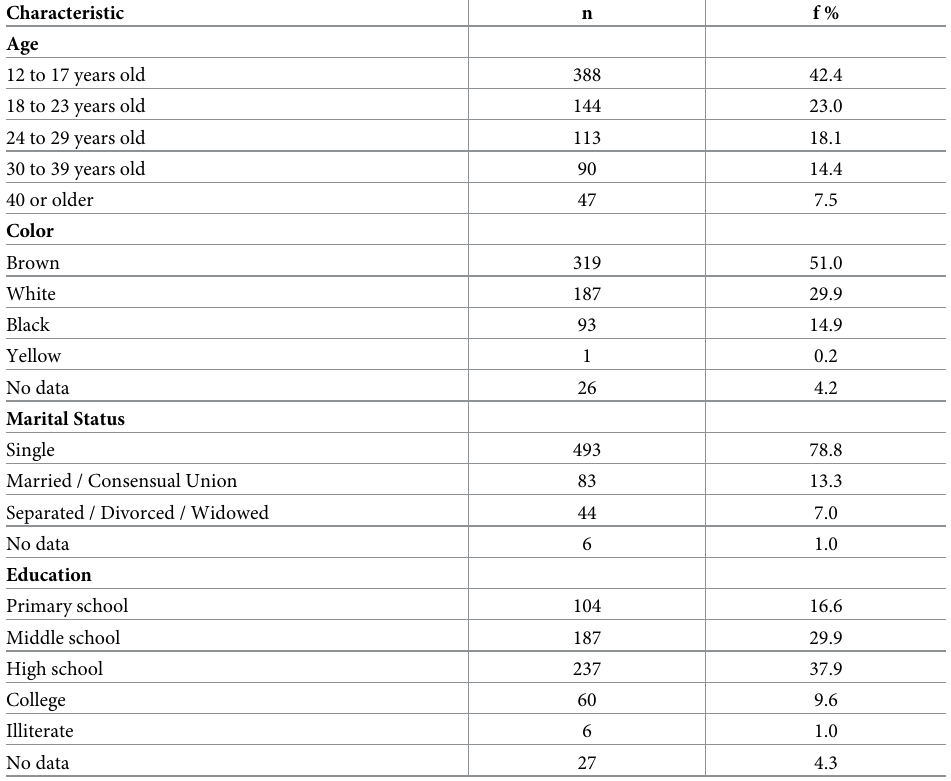
Table 1. Socio-demographic characteristics of women in sexual violence situations assisted by PAVI´VIS between 2010 and 2019 (N = 915).